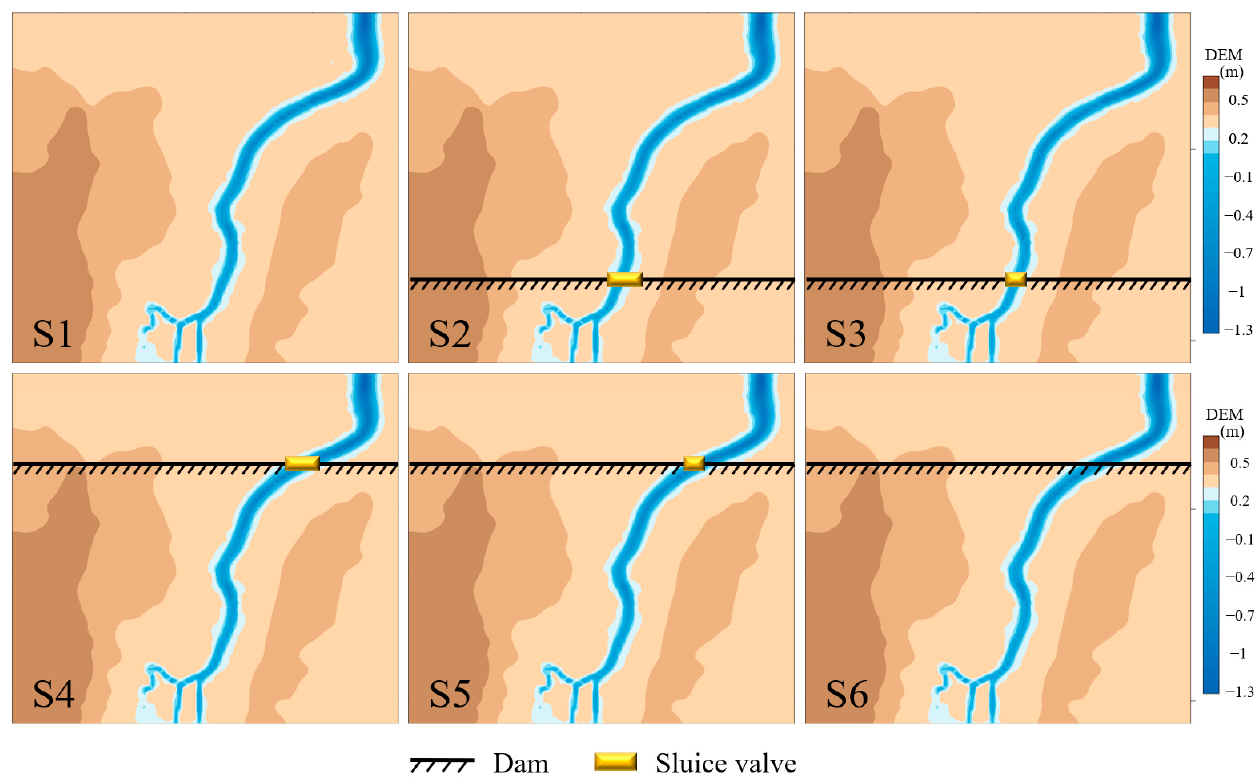
Figure 4. Dam and gate valve settings in scenarios S1–S6.